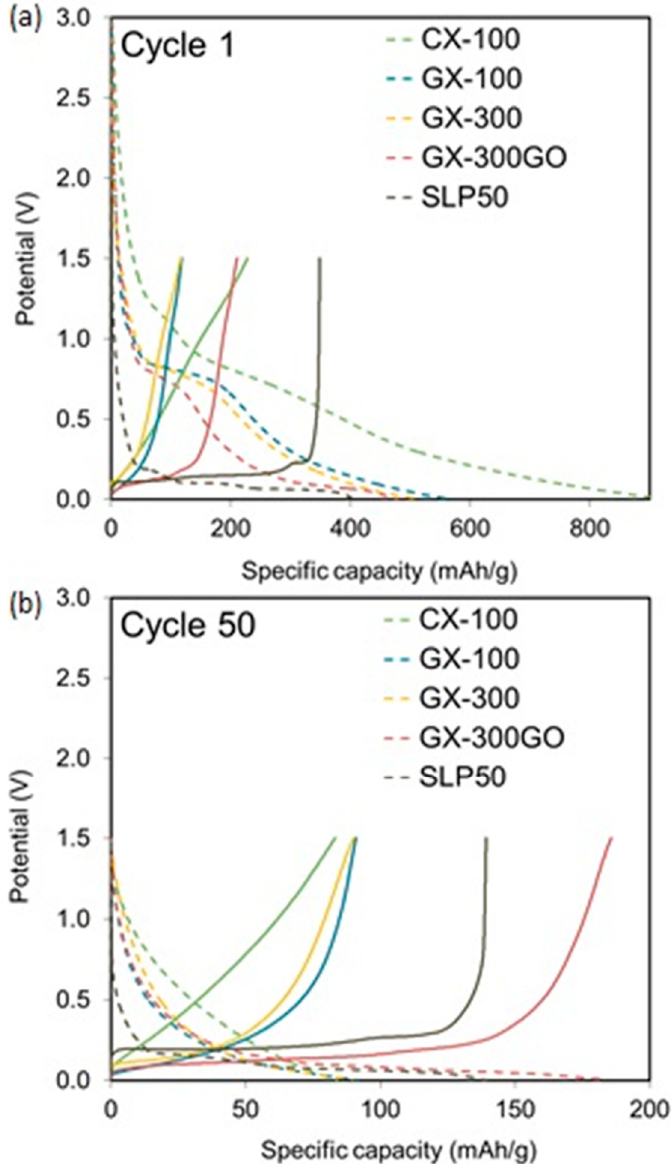
Figure 5. Discharge (dotted) and charge (solid) curves at a rate of C/5 for the xerogels studied during the 1st ( a ) and the 50th cycle ( b